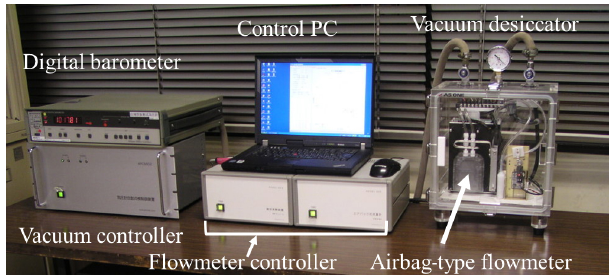
Figure 4. Actual appearance of the automated measurement system of the pump efficiency for the ECC ozonesonde.